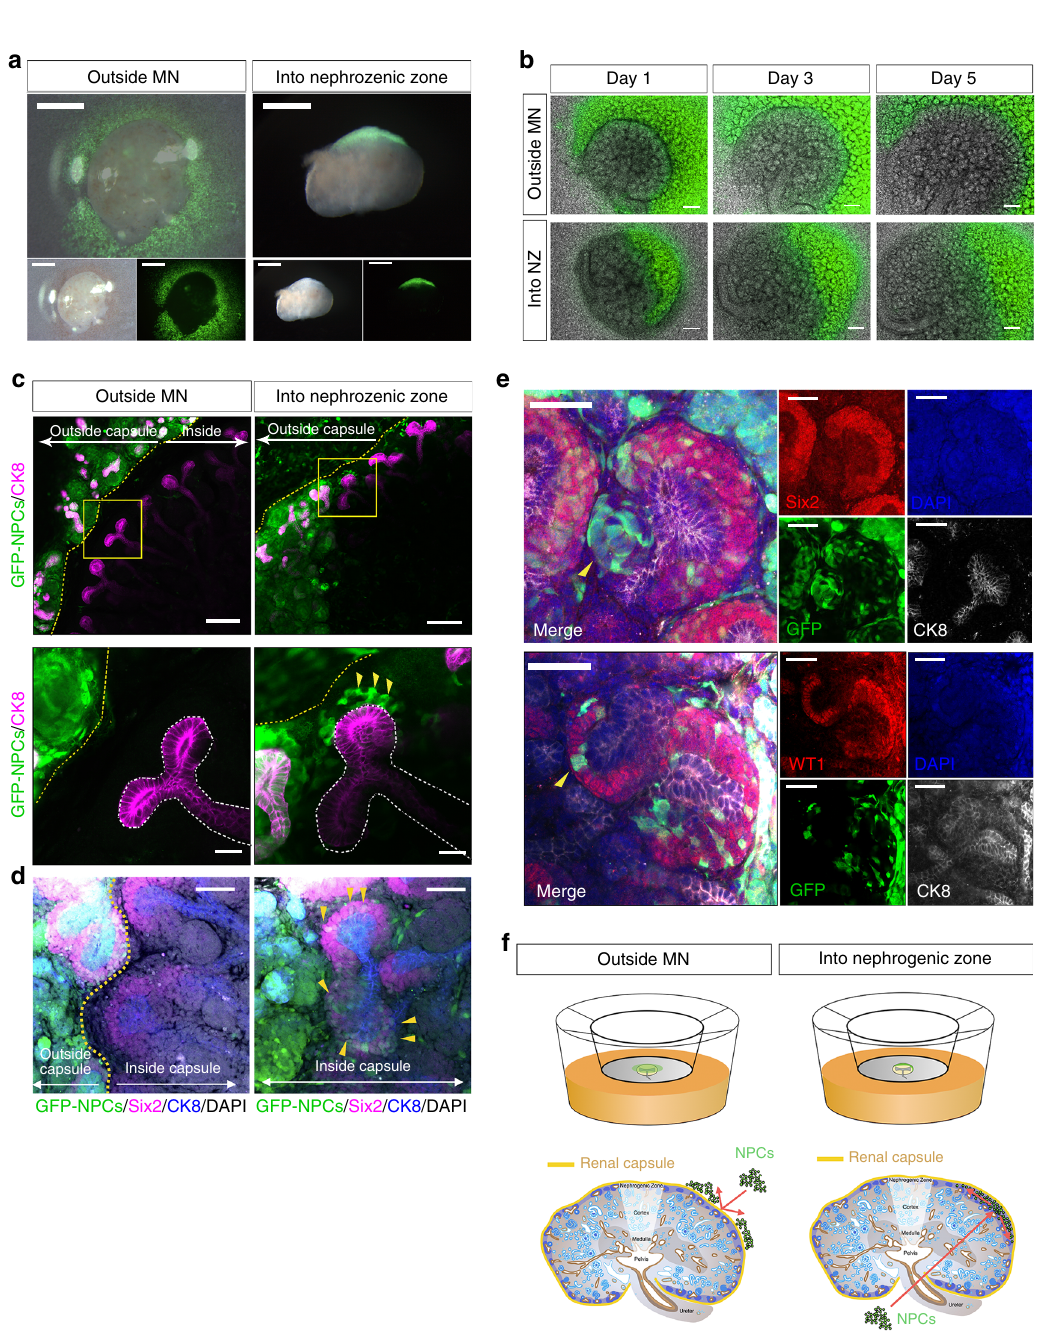
Fig. 1 Integration of nephron progenitor cells (NPCs) into the cap mesenchyme (CM). a Nephron progenitor cells (NPCs) that expressed green fl uorescent protein (GFP) were observed transplanted outside the metanephros (MN) or into the nephrogenic zone (NZ) under the renal capsule of E13.5 wild-type MNs (scale bar, 500 µ m). b MN-injected NPCs were cultured at the air − fl uid interface on a polycarbonate fi lter. The NPCs were observed under a fl uorescence microscope (scale bar, 200 µ m). c The MN was costained with cytokeratin-8 (CK8) to label the ureteric bud and GFP-NPCs of donor cells (arrows). After 5 days of culture, a few cells were integrated into the CM at the inside renal capsule of the injected NPCs (scale bar, left: 100 µ m, right: 20 µ m). d Left column: transplantation of GFP-NPCs outside the MN; right column: transplantation of GFP-NPCs into the NZ area. Integrated GFP-positive cells expressed Six2 (yellow arrow; scale bar, 50 µ m). e Integrated GFP-NPCs were observed on some C-shaped nephrons with mosaic formation in the NZ group (scale bar, 50 µ m). f Schematic representation of NPC transplantation into the nephrogenic zone (right) or the outside MN (left). Schematic of metanephros adapted from GUDMAP